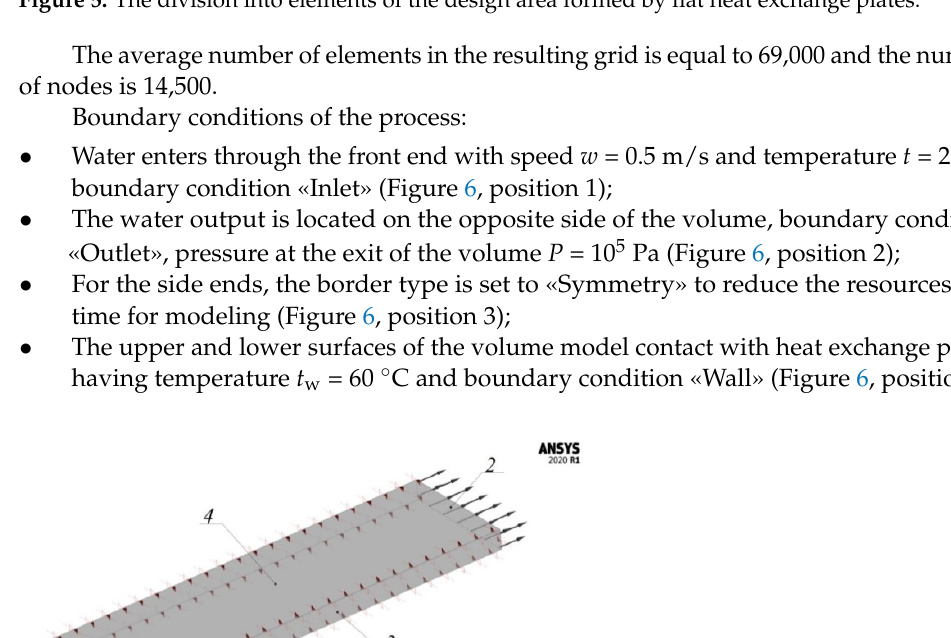
Figure 5. The division into elements of the design area formed by flat heat exchange plates.